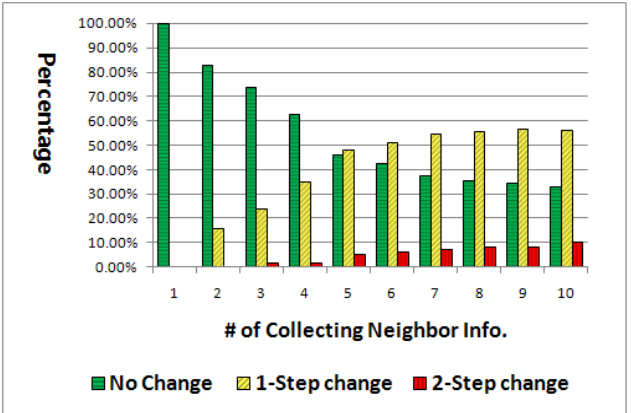
Figure 8. Ratio of node relation changes on sequential flooding.